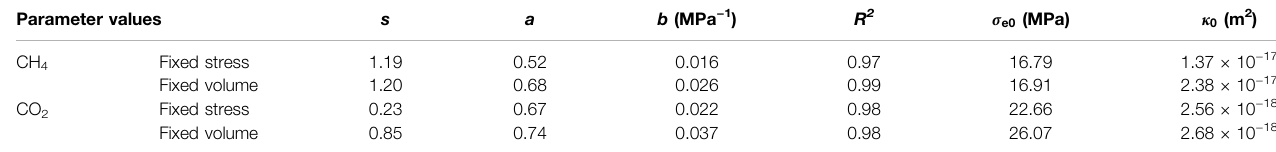
TABLE 3 | List of the values of σ e 0 and κ 0 used for fi tting and parameter values obtained from the best fi tting of Eq. 2 to the permeability data shown in Figure 10 . Parameter values